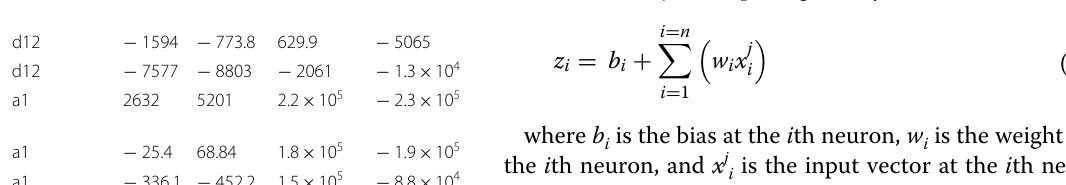
Table 4 d12 and a1 of voltage signal statistics during the unstable, stable, and faulty conditions Voltage Co‑efficient Mean signal during value